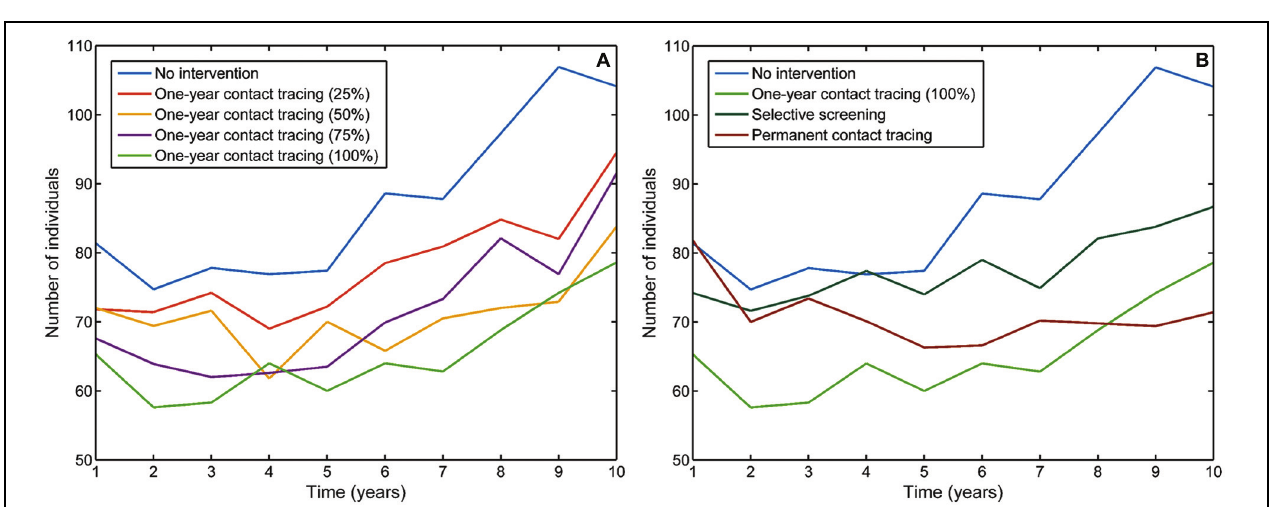
FIGURE 8 | Evolution of annual TB cases during 10 simulated years, depending on the type of screening implemented, compared with the no-intervention scenario. (A) 1-year contact tracing with 25, 50, 75, and 100% success detecting new infections; (B) 1-year contact tracing with 100% success detecting new infections, selective screening (immigrants and HIV + ), and permanent contact tracing (see details in